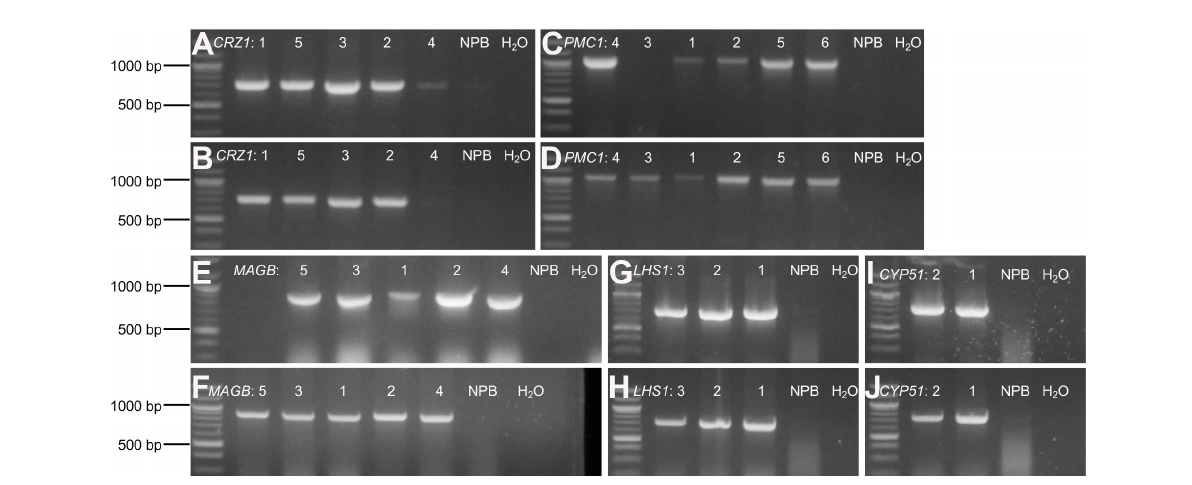
FIGURE4 Confirm positive T0 transgenic rice through gDNA PCR. (A–J) Agarose gel electrophoresis for amplified target fragments of candidate HIGS gene CRZ1 (A,B) , PMC1 (C,D) , MAGB (E,F) , LHS1 (G,H) , and CYP51 (I,J) . Genomic DNA isolated from T0 transgenic rice leaves was used as templates. Primer pairs of "gus3 + corresponding target gene reverse primer" (A,C,E,G,I) and "gus4 + corresponding target gene reverse primer" (B, D, F, H, J) were used to amplify target fragments on both sides of Gus linker. Quick-Load Purple 1 kb Plus DNA Ladder from NEB was used as the DNA ladder. Arabic numbers were assigned to different rice plant lines representing individual transgenic event. Wild type Nipponbare rice plants as well as distilled water were used as negative control. The same assays were conducted to screen positive transgenic T1 and T2 generation rice